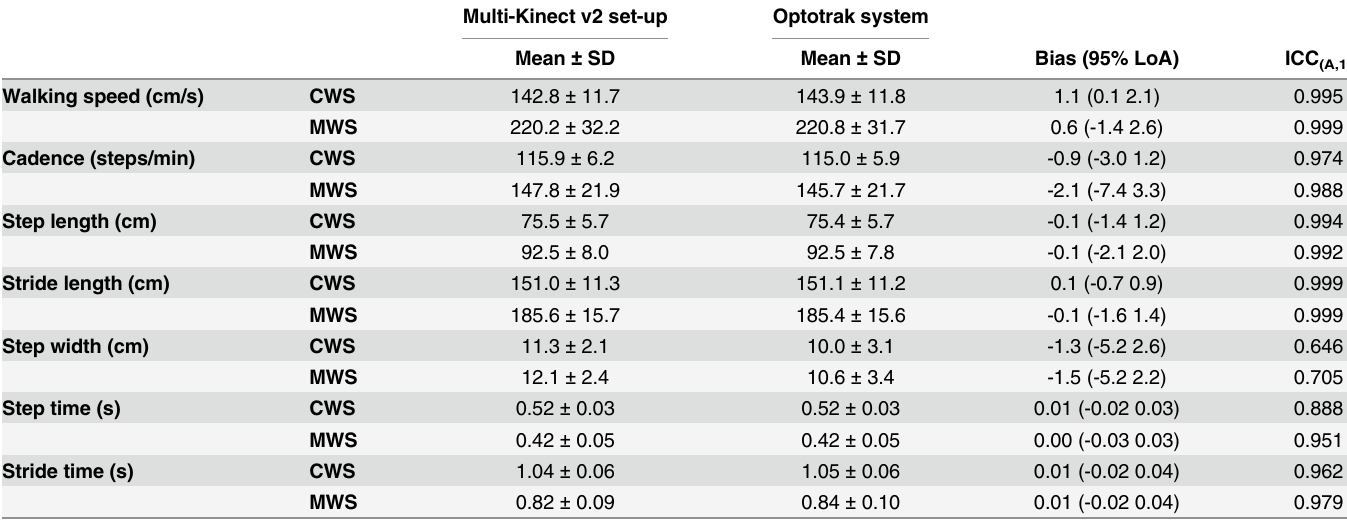
Table 2. Agreement statistics for spatiotemporal gait parameters.